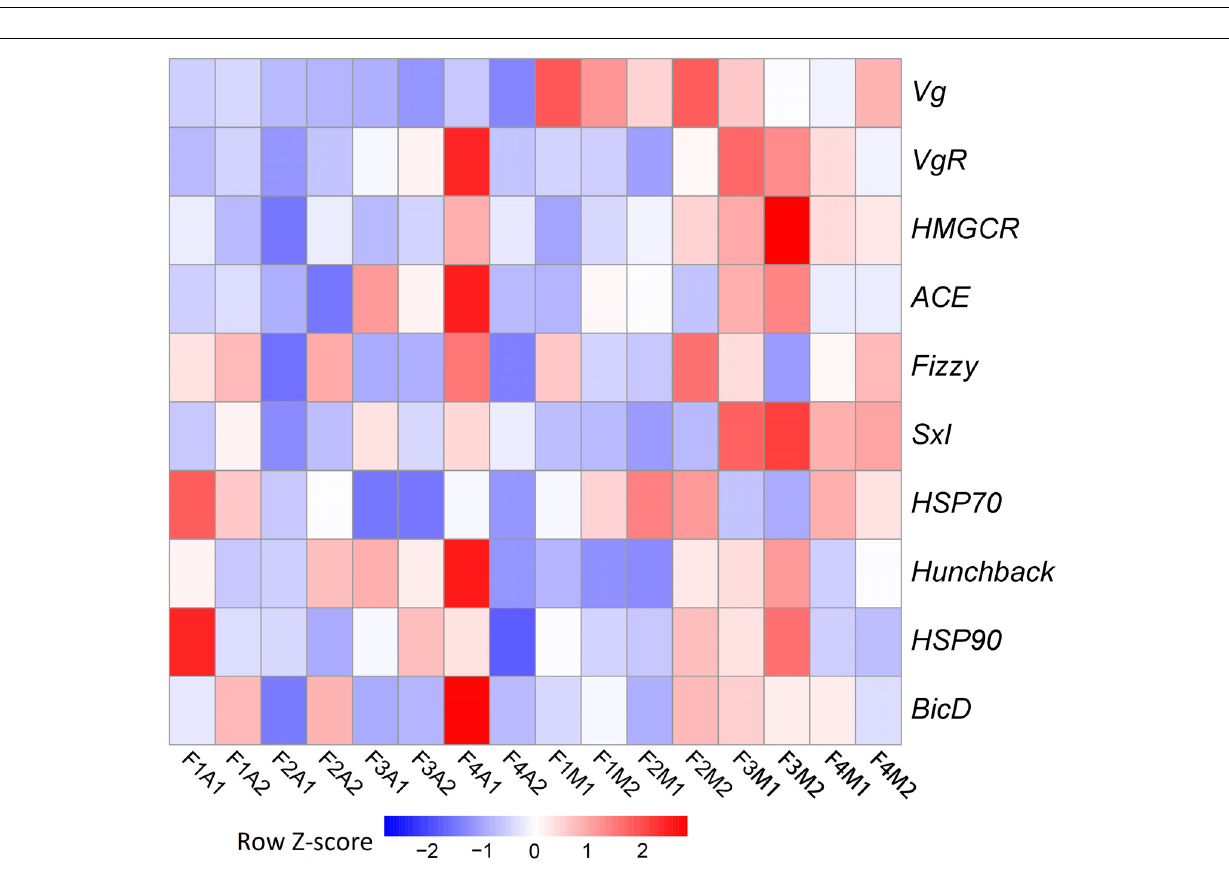
we found that both the shift to aphids and the shift back to mealybugs led to severe physiological changes in C. montrouzieri